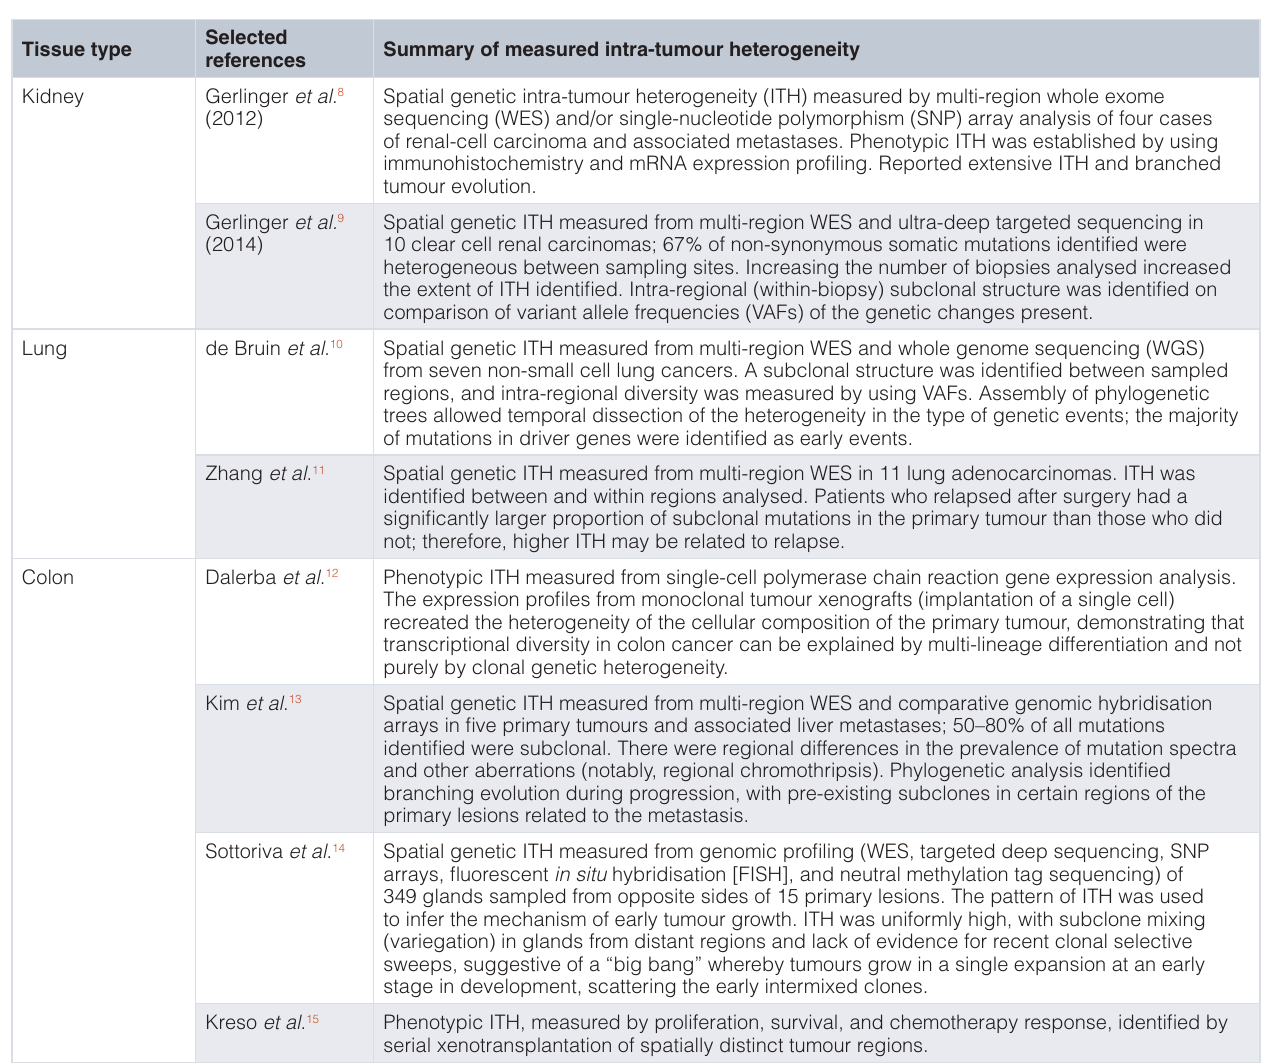
Table 1. Summary of a selection of studies revealing intra-tumour heterogeneity in space and time. Tissue